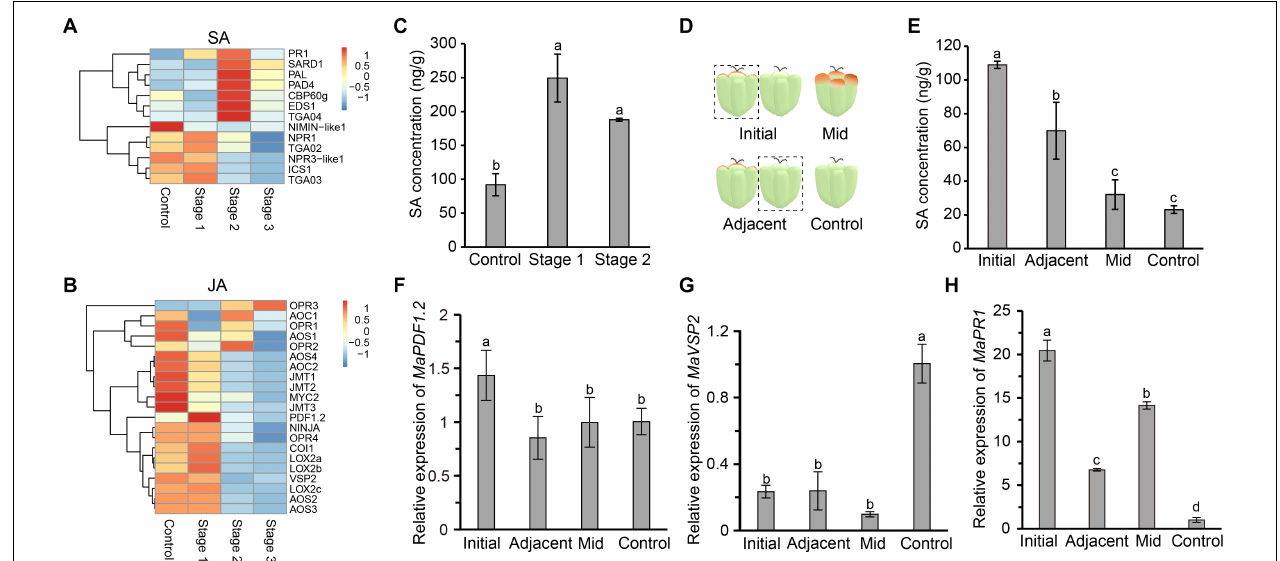
FIGURE 3 | The salicylic acid signaling pathway is induced in infected mulberry fruits. (A) The SA immune signaling pathway was activated in diseased mulberries. (B) The JA immune signaling pathway was inhibited in diseased mulberries. (C) The content of SA in diseased mulberry fruits in stage 1 and stage 2. (D) Schematic diagram of mulberry drupelet. Initial, initial infected drupelet with slight symptoms; Mid, diseased drupelet in the middle stage; Adjacent, uninfected drupelet adjacent to the initial infected drupelet; Control, uninfected drupelet from healthy mulberry. (E) The content of SA in different drupelets. (F–G) The expression of the marker genes MaPDF1.2 and MaVSP2 in the JA immune signaling pathway in different drupelets. (H) The expression of the marker gene MaPR1 in the SA immune signaling pathway in different drupelets. MaActin was used as an internal reference gene. Different letters (a, b) indicate statistical differences ( P < 0.05) ( n = 3, one-way ANOVA with post hoc Duncan’s test). The q-PCR analyses were repeated twice, and two mulberry fruits were used for each